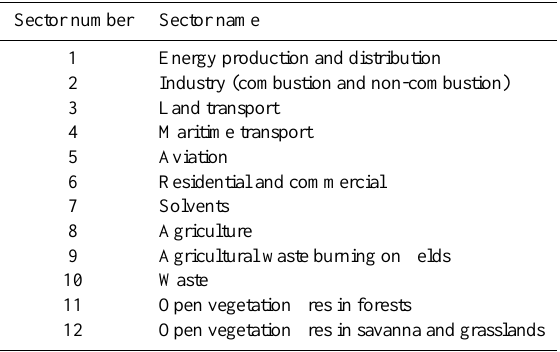
Table 3. List of